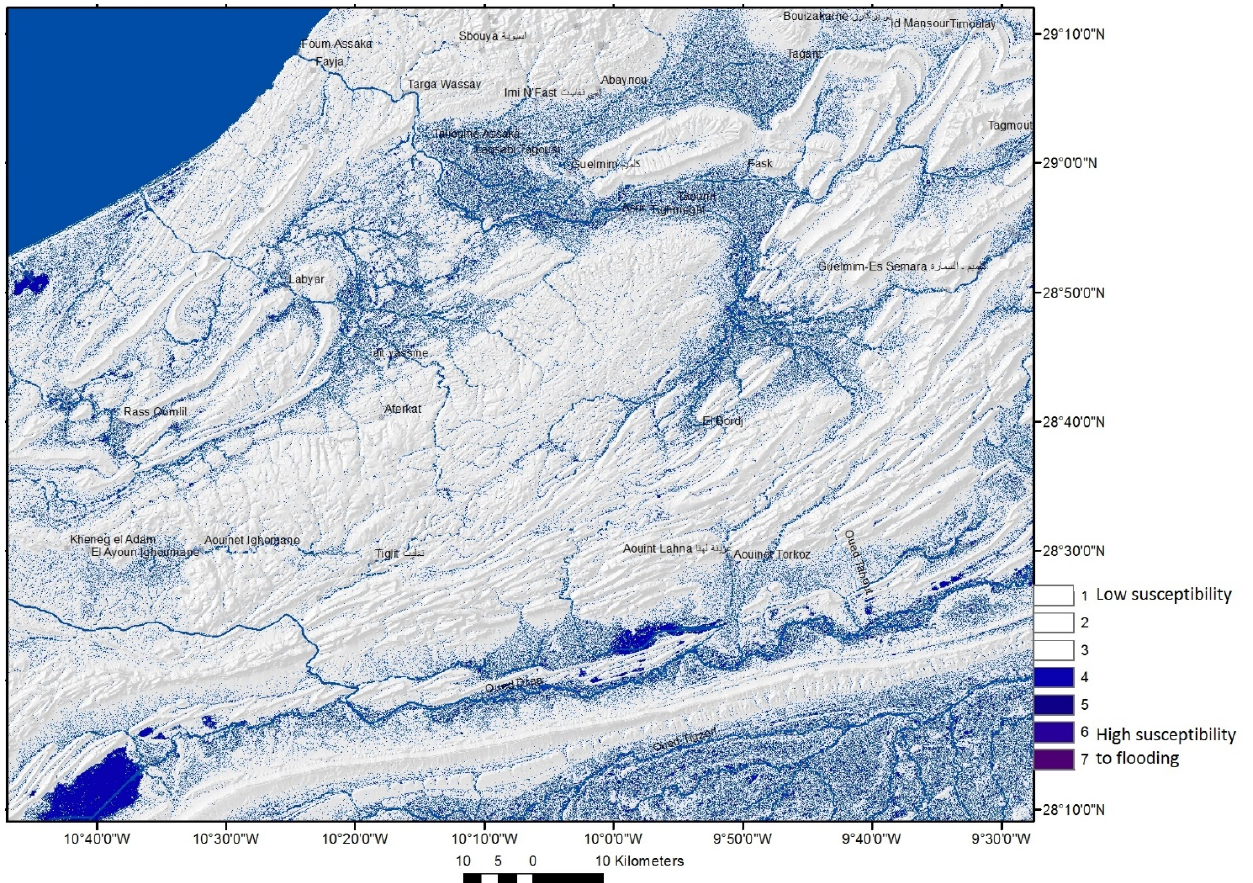
Figure 9. Areas susceptible to flooding according to their morphometric